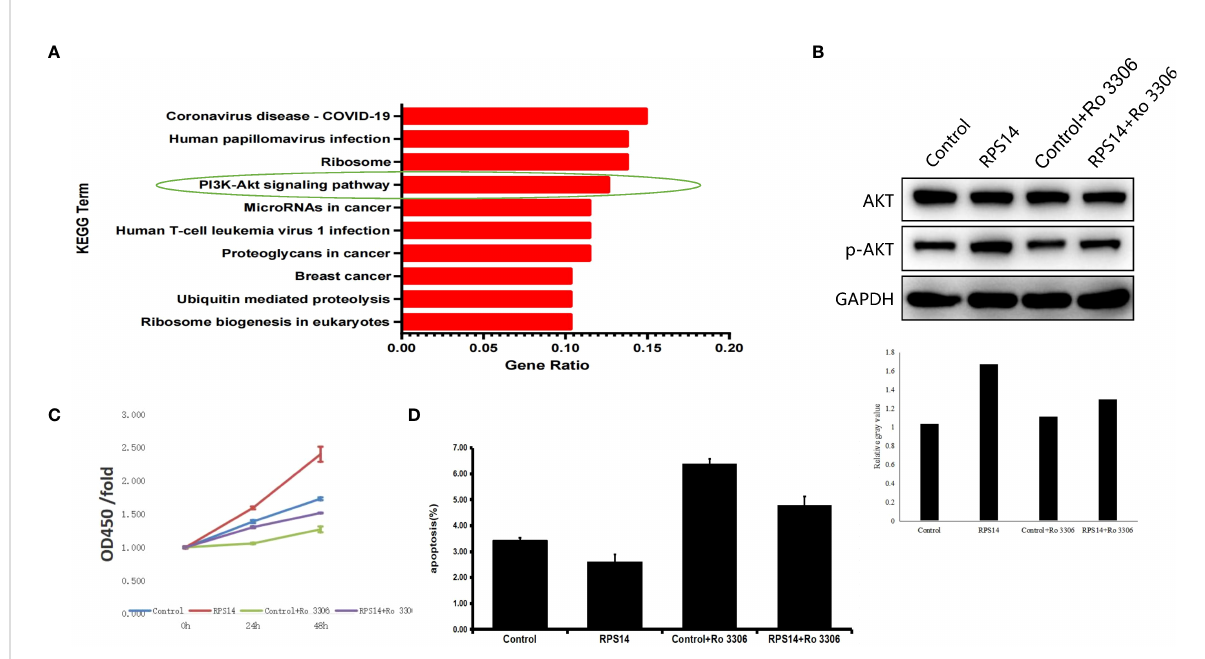
FIGURE 6 RPS14 plays a role in CRC via PI3K-Akt signaling pathway. (A) Gene-set enrichment analysis of RPS14 by KEGG was performed. (B) Western blotting was used to assess the phosphorylation level of Akt in cells treated by selective CDK1 inhibitor (Ro-3306) with or without RPS14 overexpression. (C, D) CCK-8 (C) and fl ow cytometry (D) were used to detect the effects of Ro-3306 on cell growth and apoptosis with or without RPS14 overexpression. Data were shown as mean ±